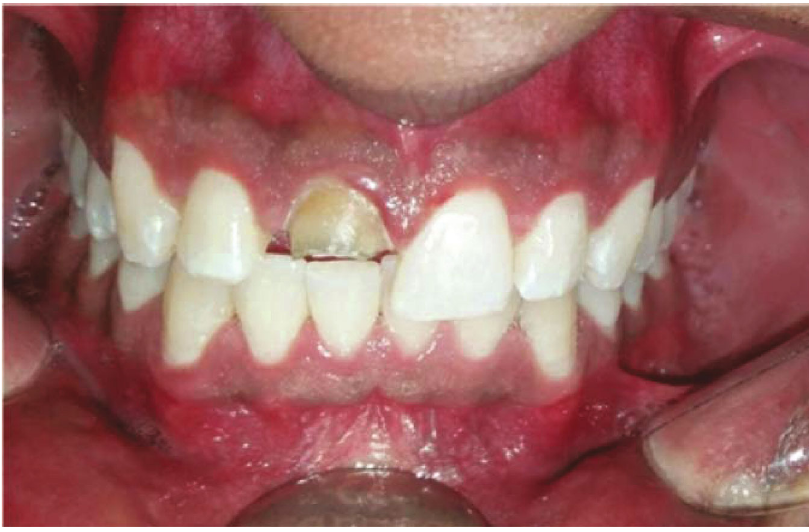
Figure 1: Initial clinical appearance with melanic pigmentations.